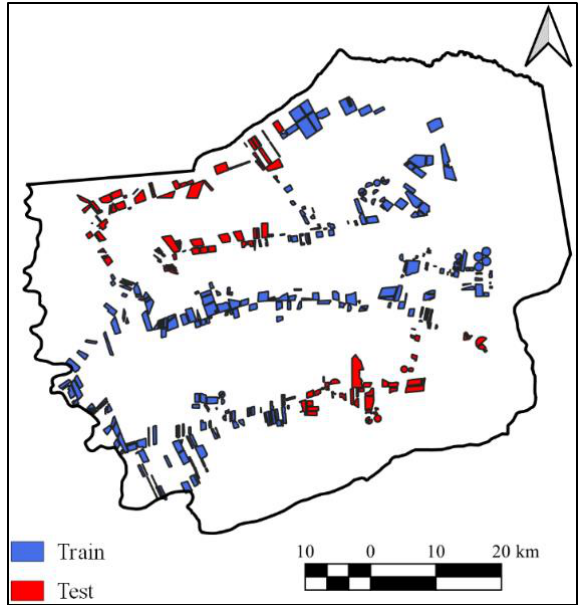
Figure 1. Luís Eduardo Magalhães municipality boundaries with ground truth